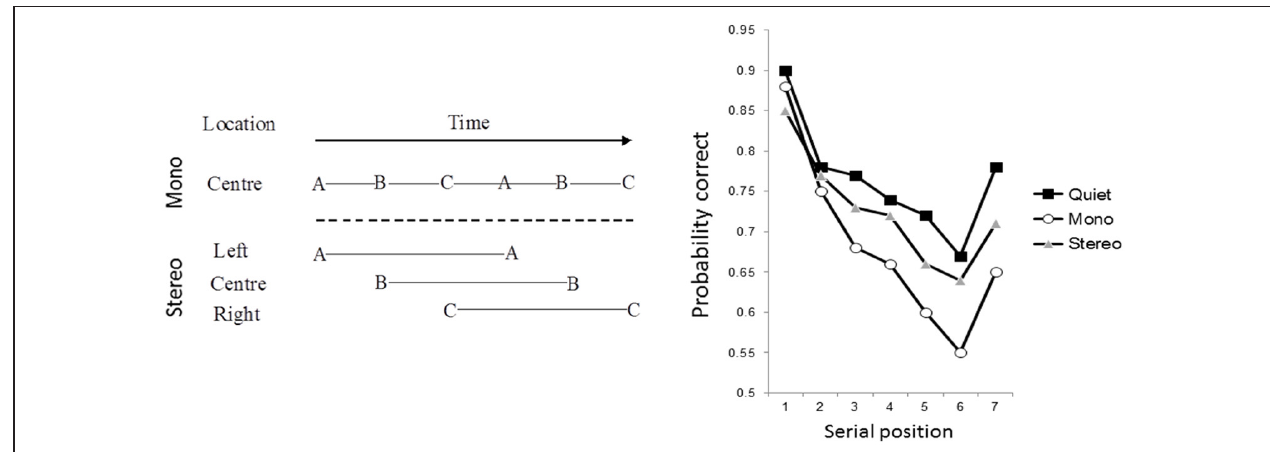
FIGURE 2 | The effect of the perceptual organization of task-irrelevant sound on its ability to disrupt serial recall. The successive presentation of each of the three sounds (labeled A, B, and C ) to the same location leads to the